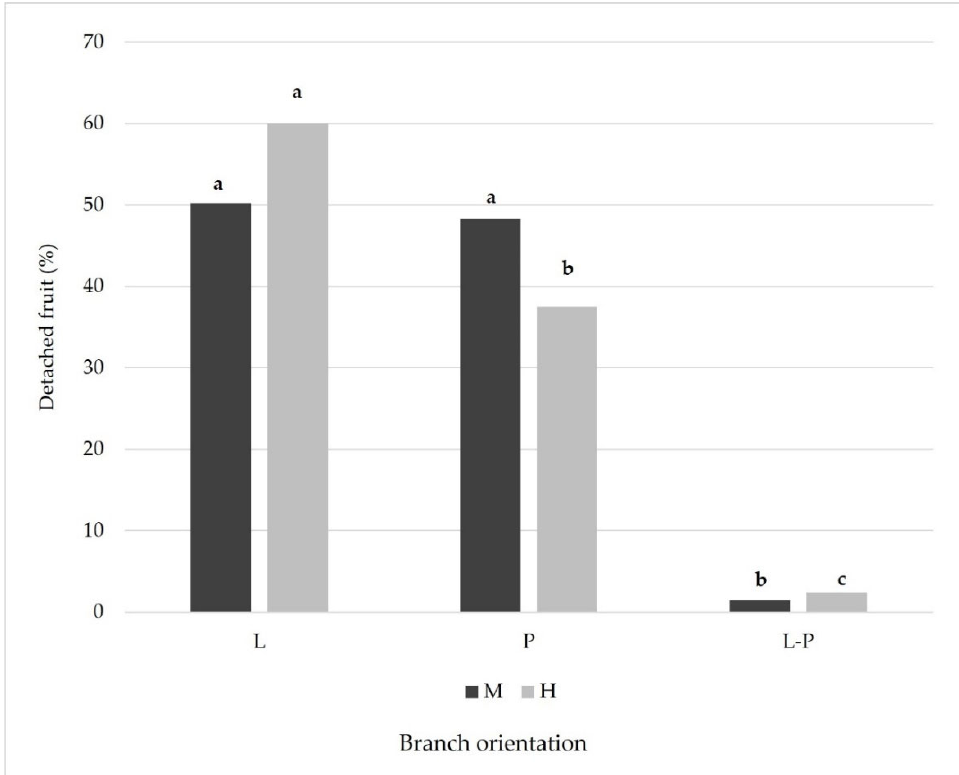
Figure 4. Total number of fruits mechanically (M) and manually (H) detached in different length classes (0–30, 30–60, 60–90, ≥ 90 cm) and orientation of branches: longitudinal (L) and perpendicular (P). Means followed by the same letter do not differ significantly at p ≤ 0.05 according to Duncan’s test. Statistical comparisons were carried out within each thinning technique.